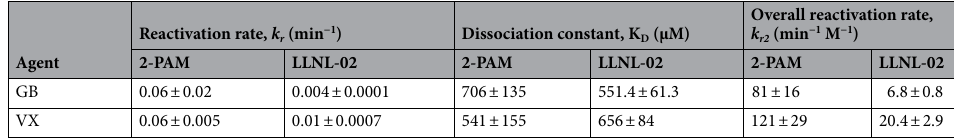
Table 1. Reactivation of nerve agent adducted acetylcholinesterase by LLNL-02 ( 1 ) and 2-PAM Oxime concentration ranged from 18 µM to 2 mM. Reaction time was 30